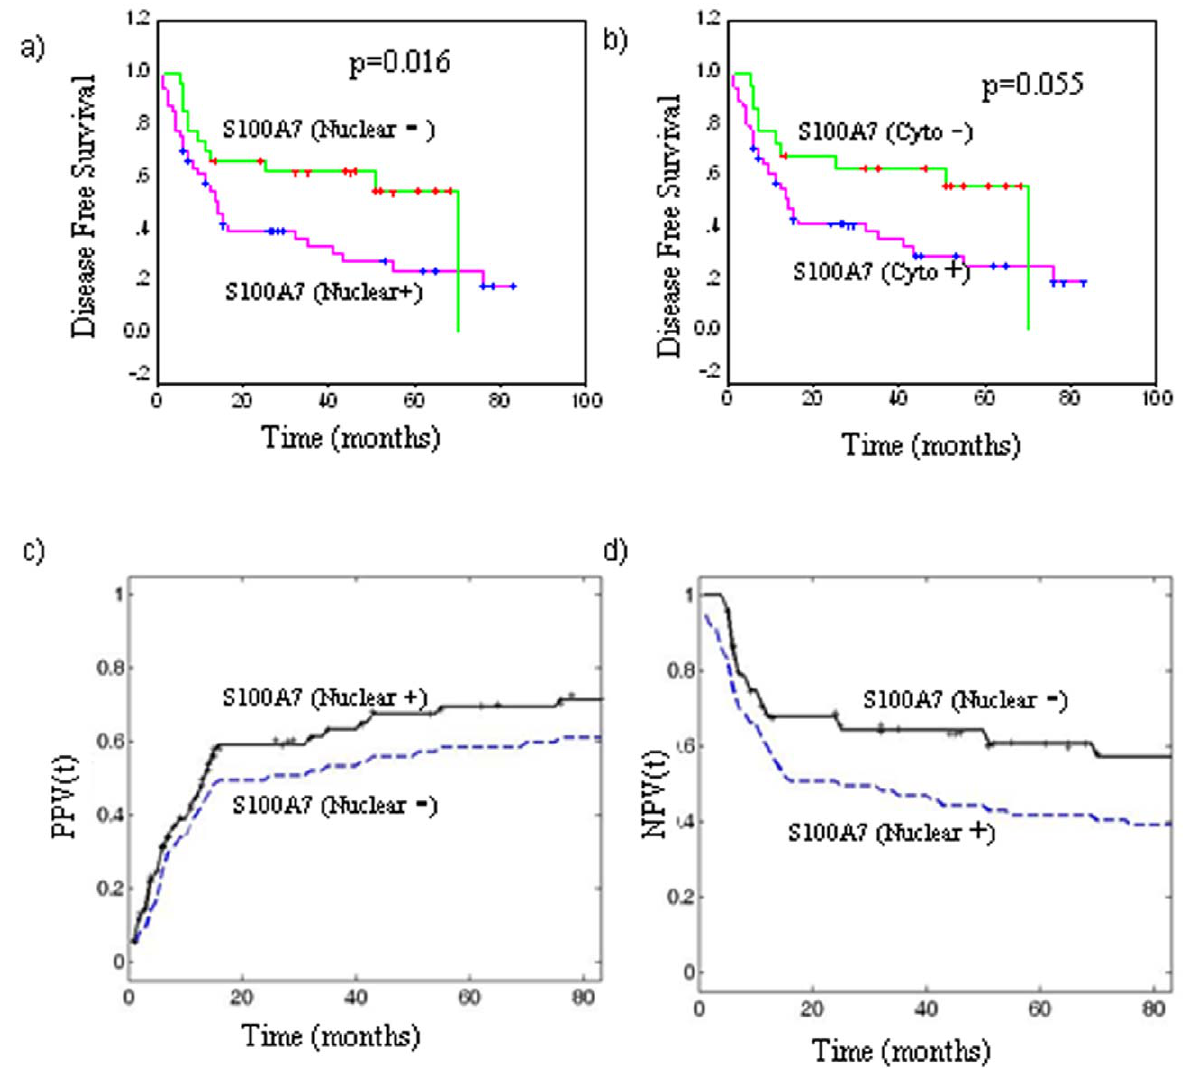
Figure 3. Evaluation of S100A7 overexpression (nuclear/cytoplasmic) as a prognostic marker in HNSCC. Kaplan–Meier estimation of cumulative proportion of disease-free survival: (a) Median time for disease-free survival (DFS; no recurrence/metastasis) in HNSCC patients showing nuclear immunostaining of S100A7 was 13 months, whereas in patients showing no/faint S100A7 immunostaining in nucleus median DFS was 70 months (p=0.016); (b) In patients showing increased cytoplasmic S100A7 expression the median DFS was 14 months compared with HNSCC that showed mild or moderate cytoplasmic immunostaining (median DFS =70 months, p=0.055). Time-dependent Positive and Negative Predictive Values (PPV(t), NPV(t)) of nuclear S100A7 expression. (c) PPV(t) for time to cancer relapse for 49 HNSCC patients with S100A7 + (solid line) and for all 77 HNSCC patients with survival data (dashed line); d) NPV(t) for time to cancer relapse for 28 HNSCC patients with S100A7 2 (solid line).